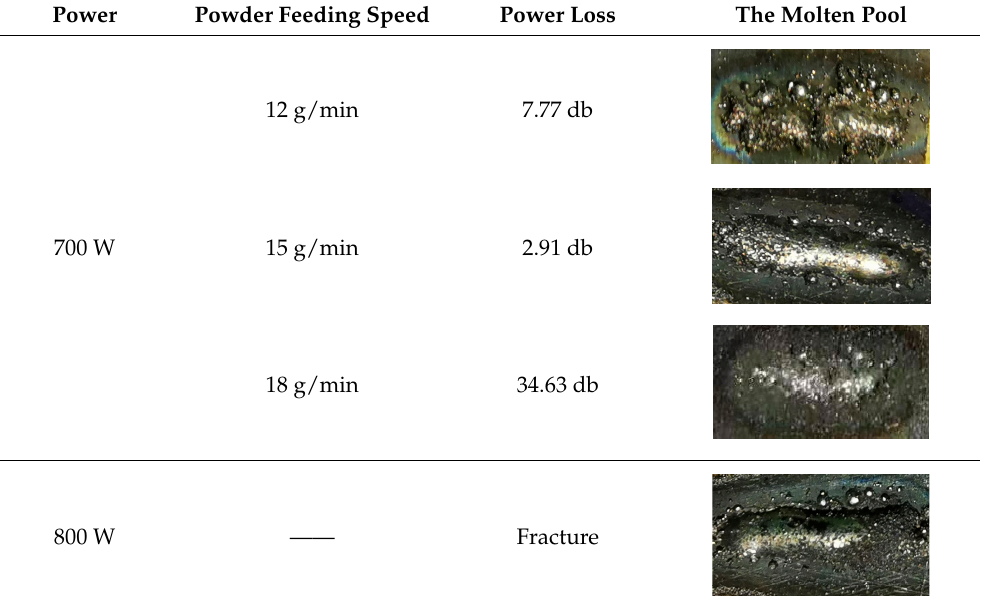
Table 3. Cont. Power Powder Feeding